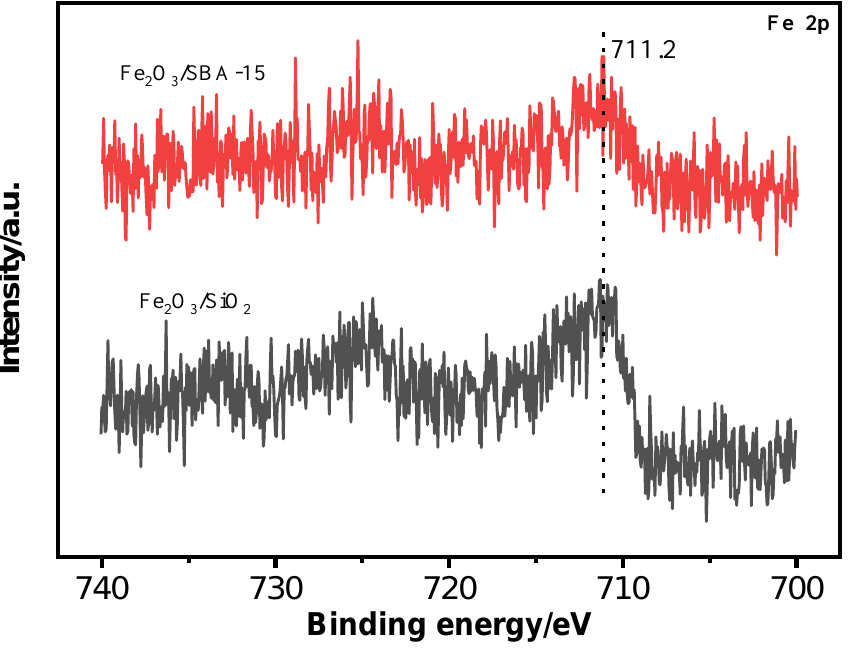
Figure 4. Fe 2p XPS spectra of Fe 2 O 3 /SBA-15 and Fe 2 O 3 /SiO 2 .